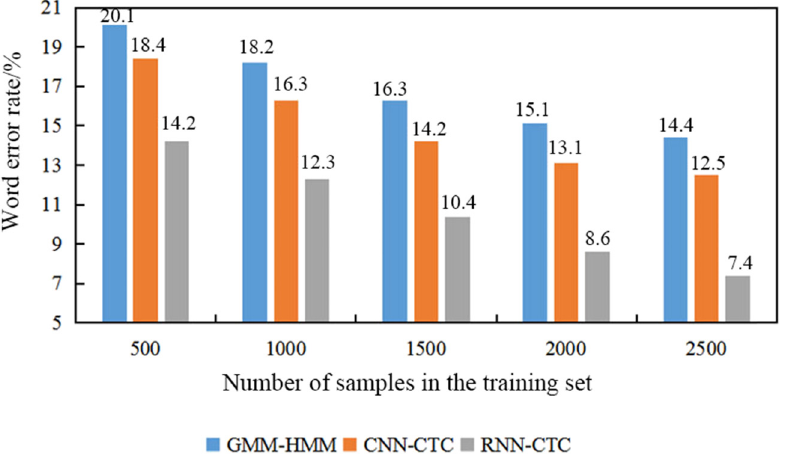
Figure 3: Recognition performance of three speech recognition algorithms trained on training sets with di ff erent numbers of